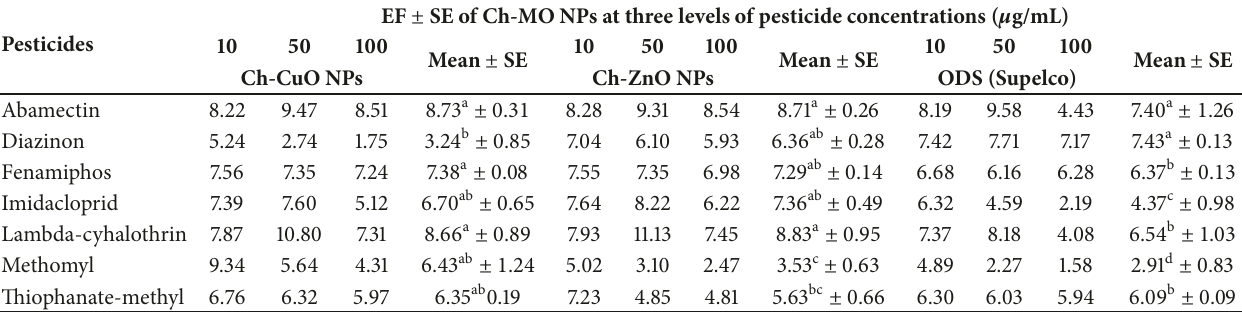
Table 7: Enrichment factor (EF) of Ch-Si MNPs for adsorption of different pesticides from water sample.